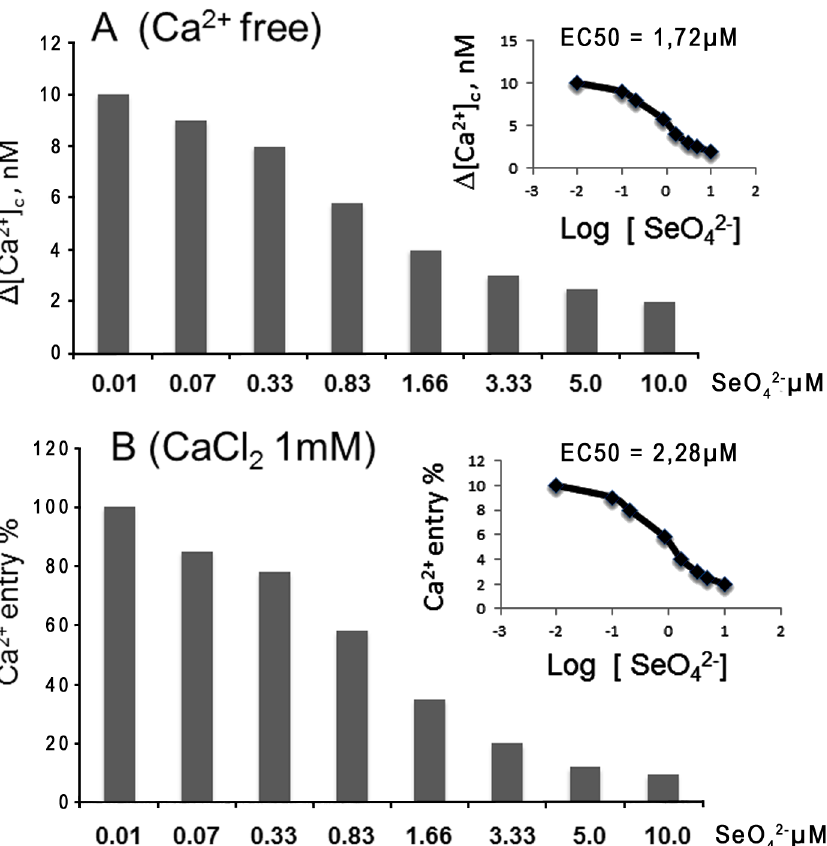
Fig 2. SeO 42- effect on calcium homeostasis during H 2 O 2 -induced oxidative stress. Increasing concentrations (0.01–10 μ M) of SeO 42- were employed to pre-treat sheep lymphomonocytes prior to inducing oxidative stress with 1mM H 2 O 2 . Panel A shows the impact of selenium on [Ca 2+ ] c , and Panel B on Ca 2+ -entry. In both instances, results are expressed in relation to samples that were not exposed to SeO 42- . Each value corresponds to the mean calculated from 5 biological replicates ±